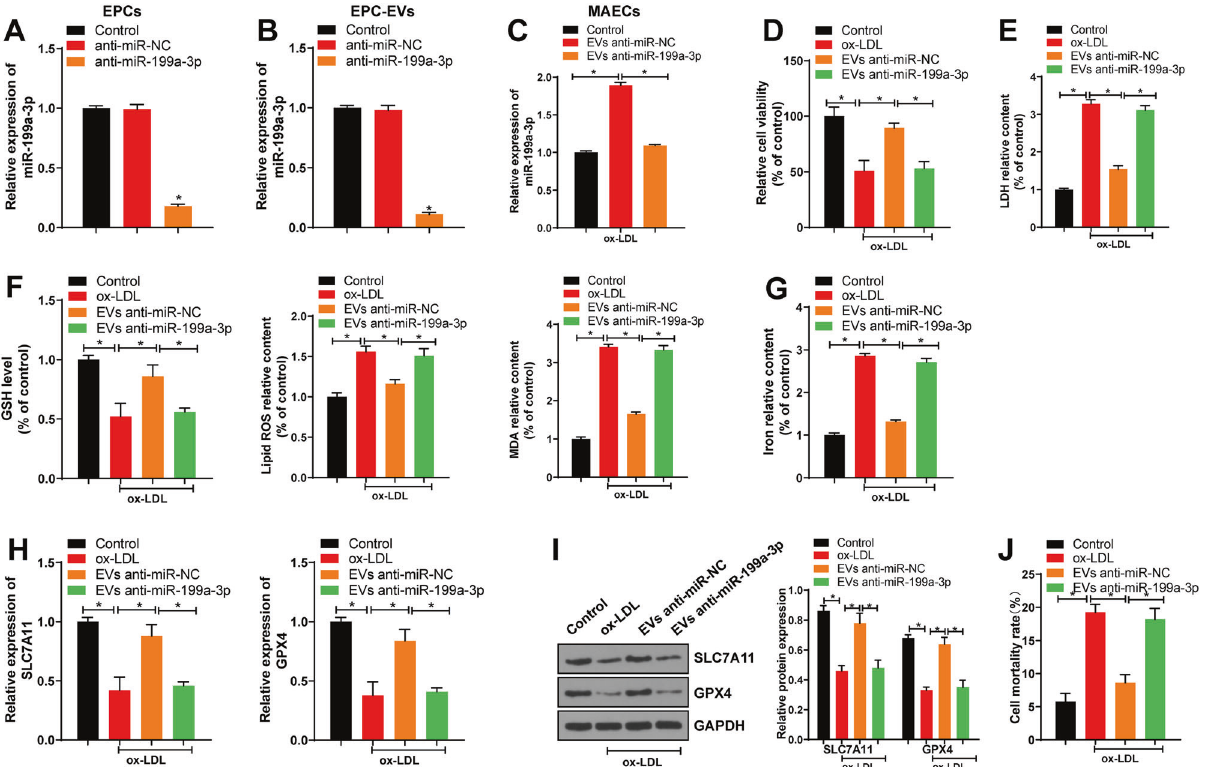
Fig. 3 EPC-EVs inhibited ferroptosis of ECs through miR-199a-3p. MAECs were isolated from the aorta of C57BL/6J mice and treated with ox-LDL alone or in combination with EVs/EVs-anti miR-199a-3p for 24 h. A The ef fi ciency of lentivirus infection was con fi rmed using qRT-PCR. B miR-199a-3p expression in EPC-EVs after lentivirus infection was detected using qRT-PCR. C miR-199a-3p expression in MAECs co-cultured with EVs/EVs-anti miR-199a-3p was detected using qRT-PCR. D The viability of MAECs co-cultured with EVs/EVs-anti miR-199a-3p was detected using CCK8 assay. E The cell damage was measured using LDH kit. F GSH consumption, lipid ROS production, and lipid peroxidation were detected using the kits. G The relative content of iron in MAECs was determined using the commercial kit. H , I SLC7A11 and GPX4 mRNA expression and protein level in MAECs were detected. J Cell death rate was detected by trypan blue staining. Each experiment was repeated three times independently. Measurement data are depicted as mean ± SD. The t test was used for the comparisons between two groups. One- way ANOVA was employed for the comparisons among multiple groups, followed by Tukey ’ s multiple comparisons test. * p <